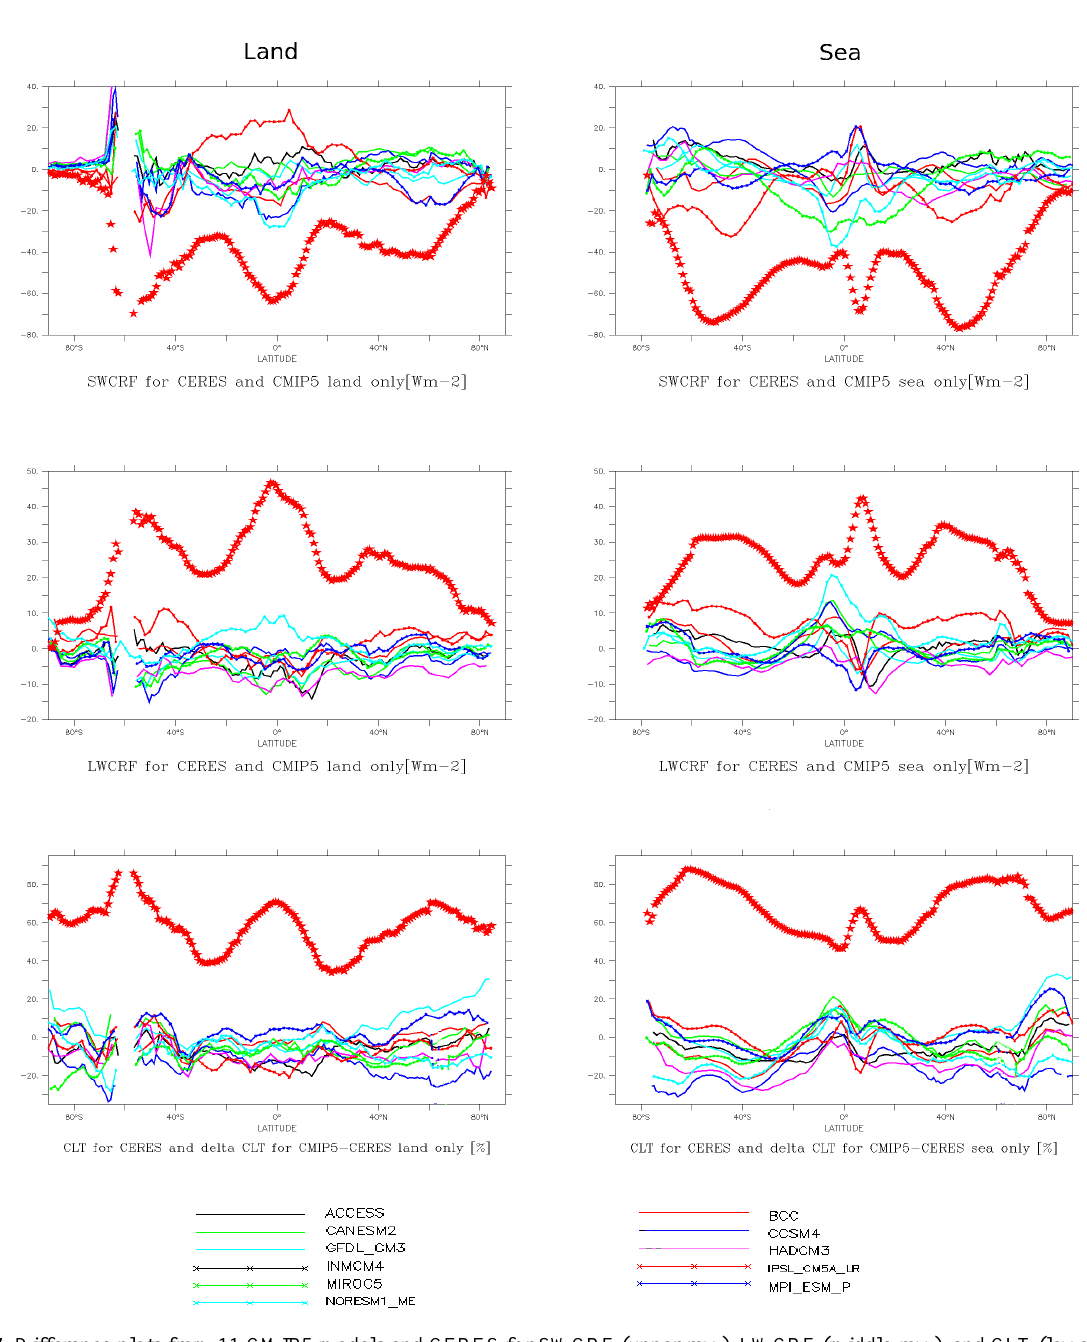
Figure 7. Difference plots from 11 CMIP5 models and CERES for SWCRF (upper row), LWCRF (middle row), and CLT (lower row) for land only (left row) and sea only (right row). The starred line shows the absolute value for CERES data. Results for CRF are given in Wm − 2 , whereas the results for CLT are given in %.